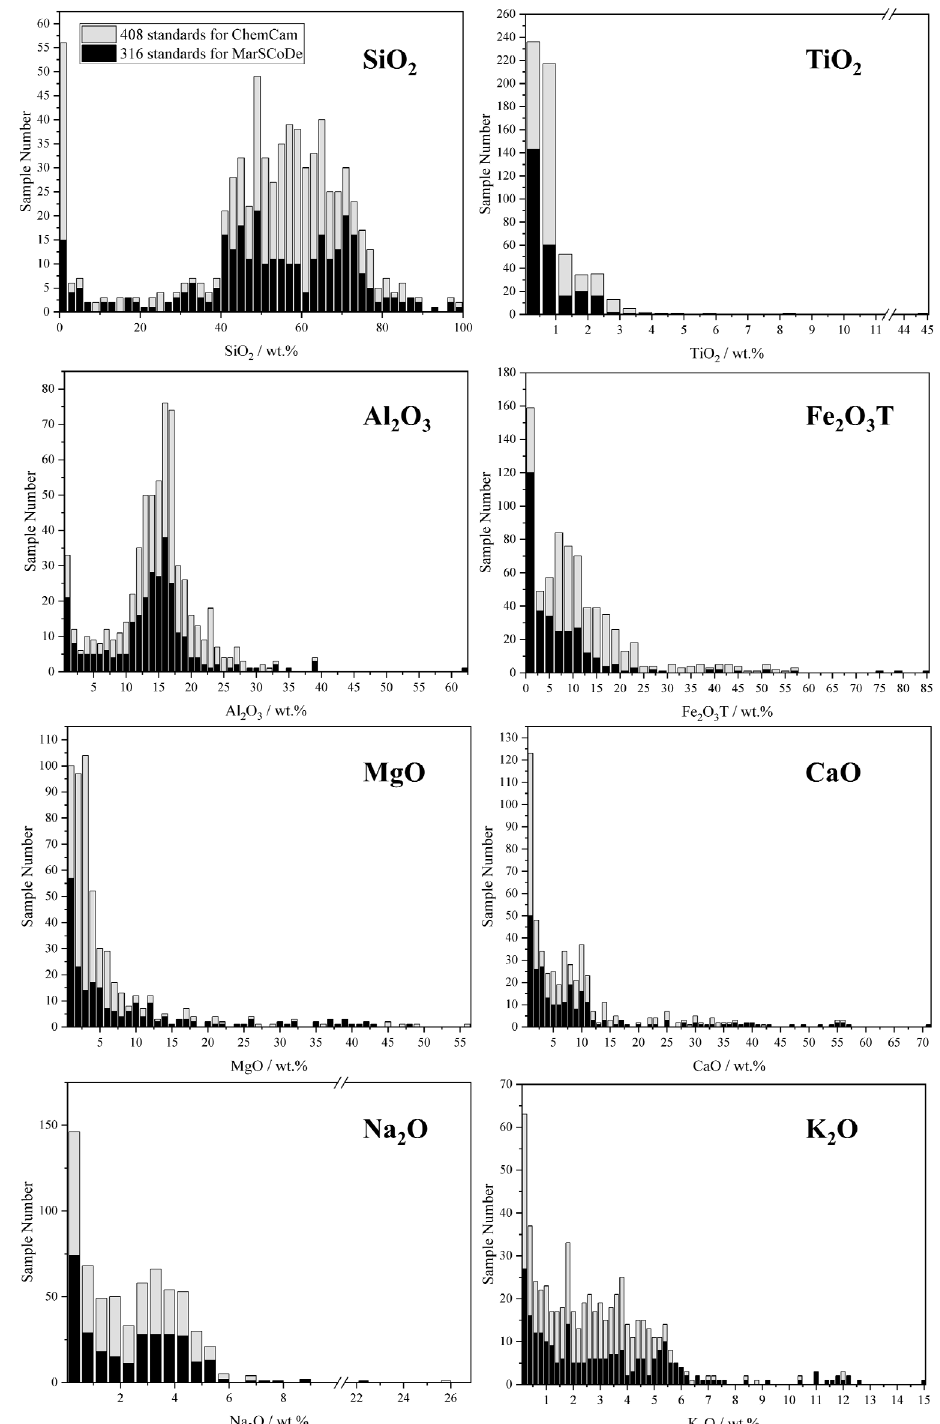
Figure 4. The distribution of oxides of major elements in 408 standards for ChemCam (gray) and 316 standards for MarSCoDe.